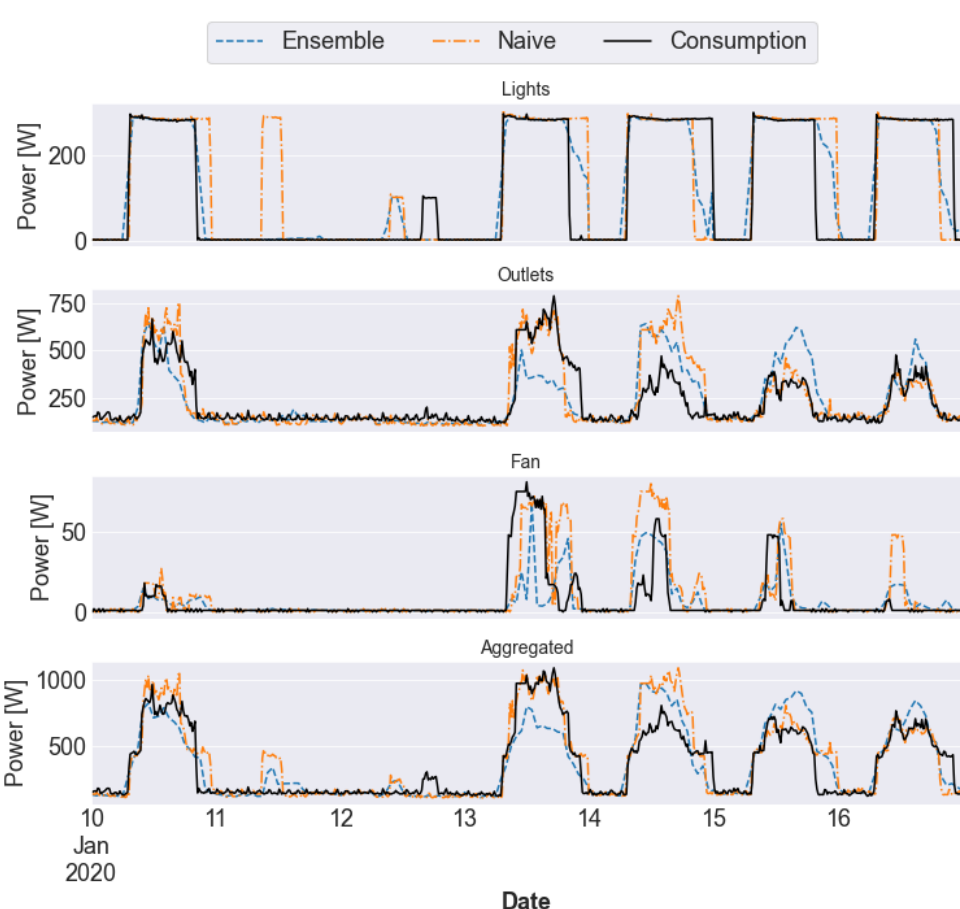
Figure 3. Load (ensemble) forecast, naive forecast, and measurements for whole test dataset on open-space B2.2 of INESC TEC (10 to 17 January